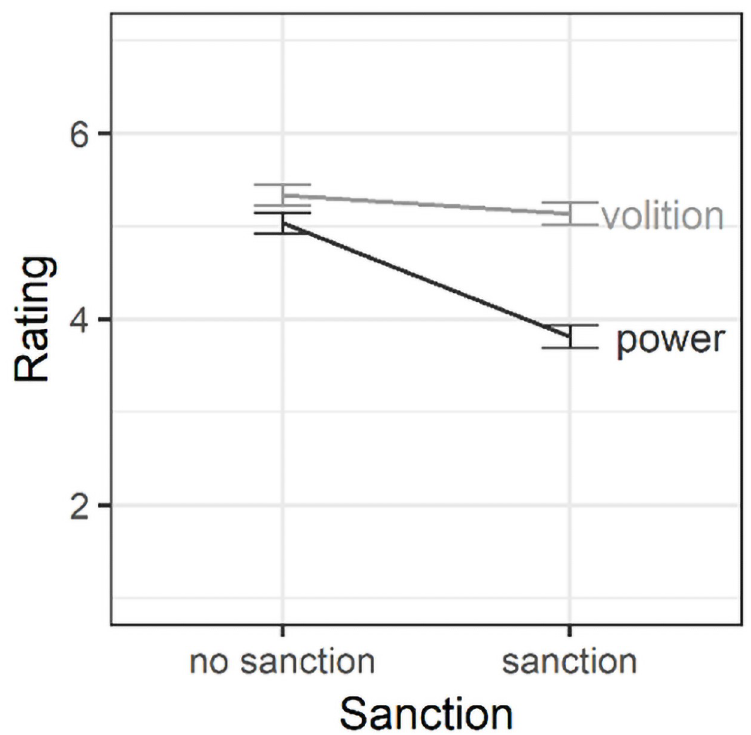
Fig 6. Effects of sanctioning on perceptions of norm violators in Study 2. Error bars are standard errors around the mean.